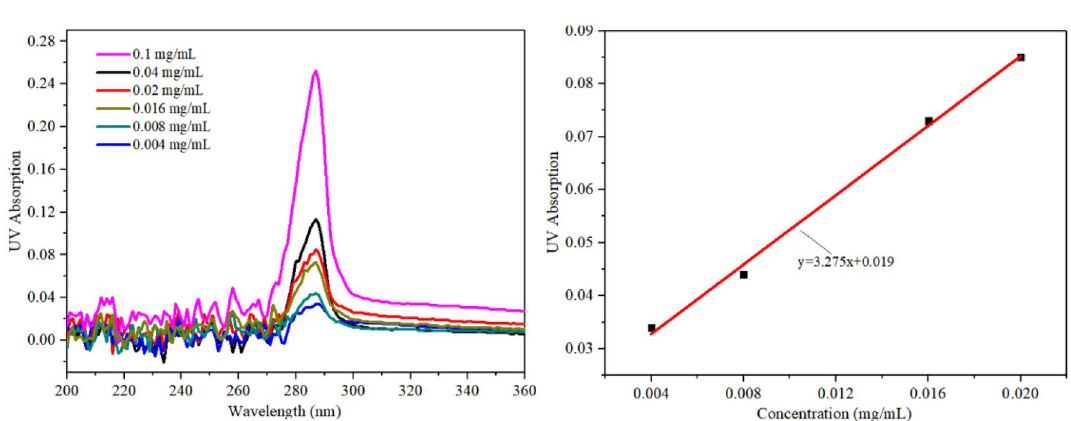
Figure 11. Effect of flow rate and input power on aerosol droplet size: ( a ) aerosol droplet size changes versus input power and liquid flow rates. ( b ) three different atomization regimes were determined by the combination of input power and flow rates.